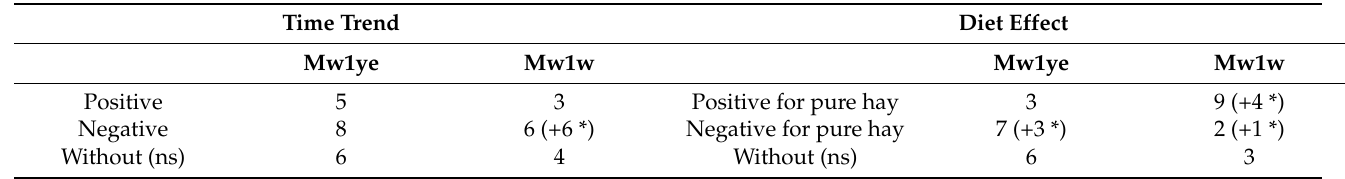
Table 3. Frequency of cows with positive, negative, or without time-related trend, and frequency of cows with positive and negative feeding effect, for the EPs Mw1ye and